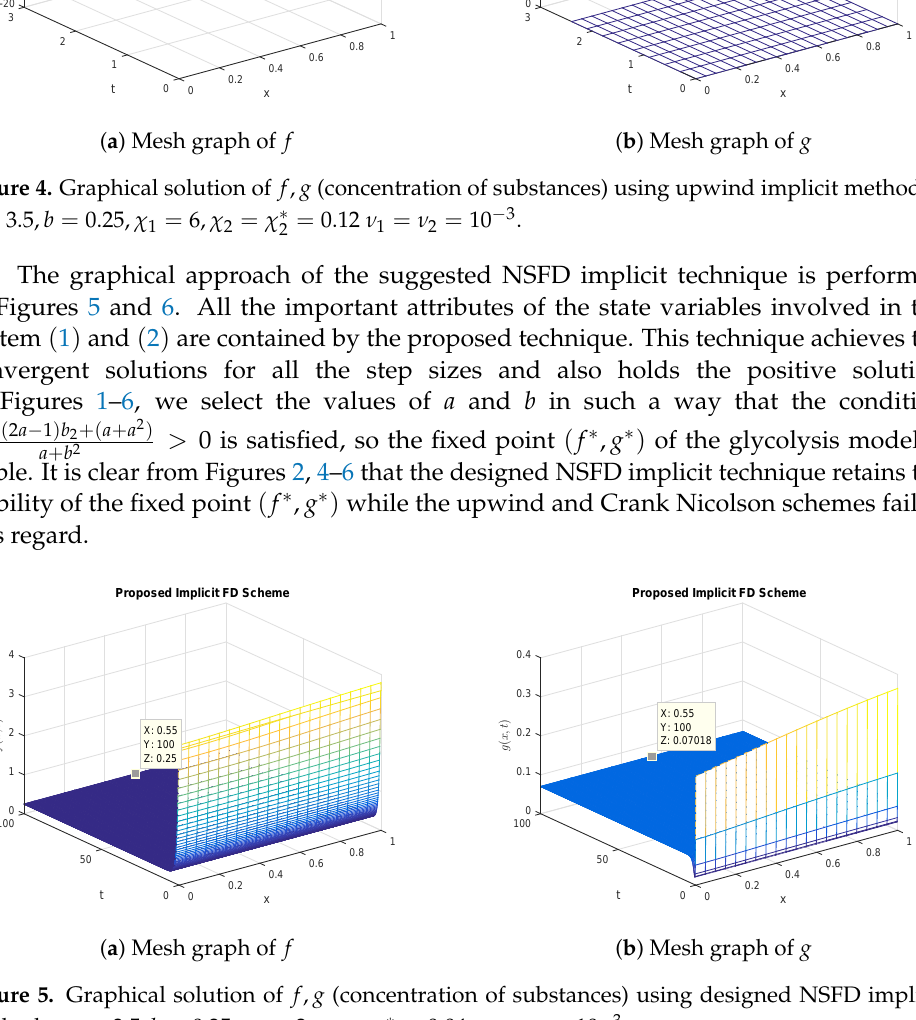
= 0.04 ν = ν = 10 − 3 2 1 2